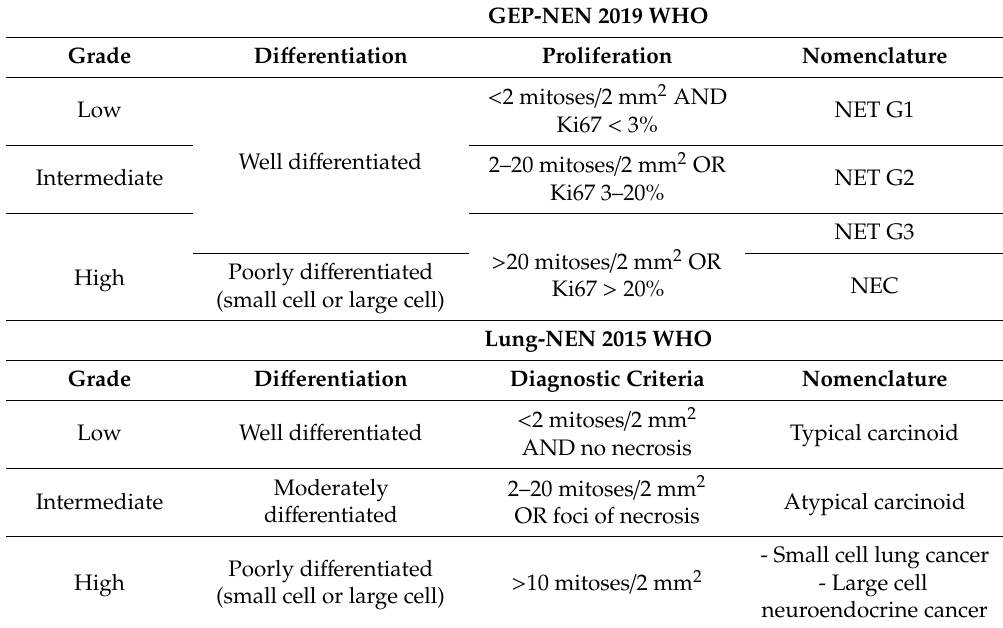
Table 1. Classification of neuroendocrine